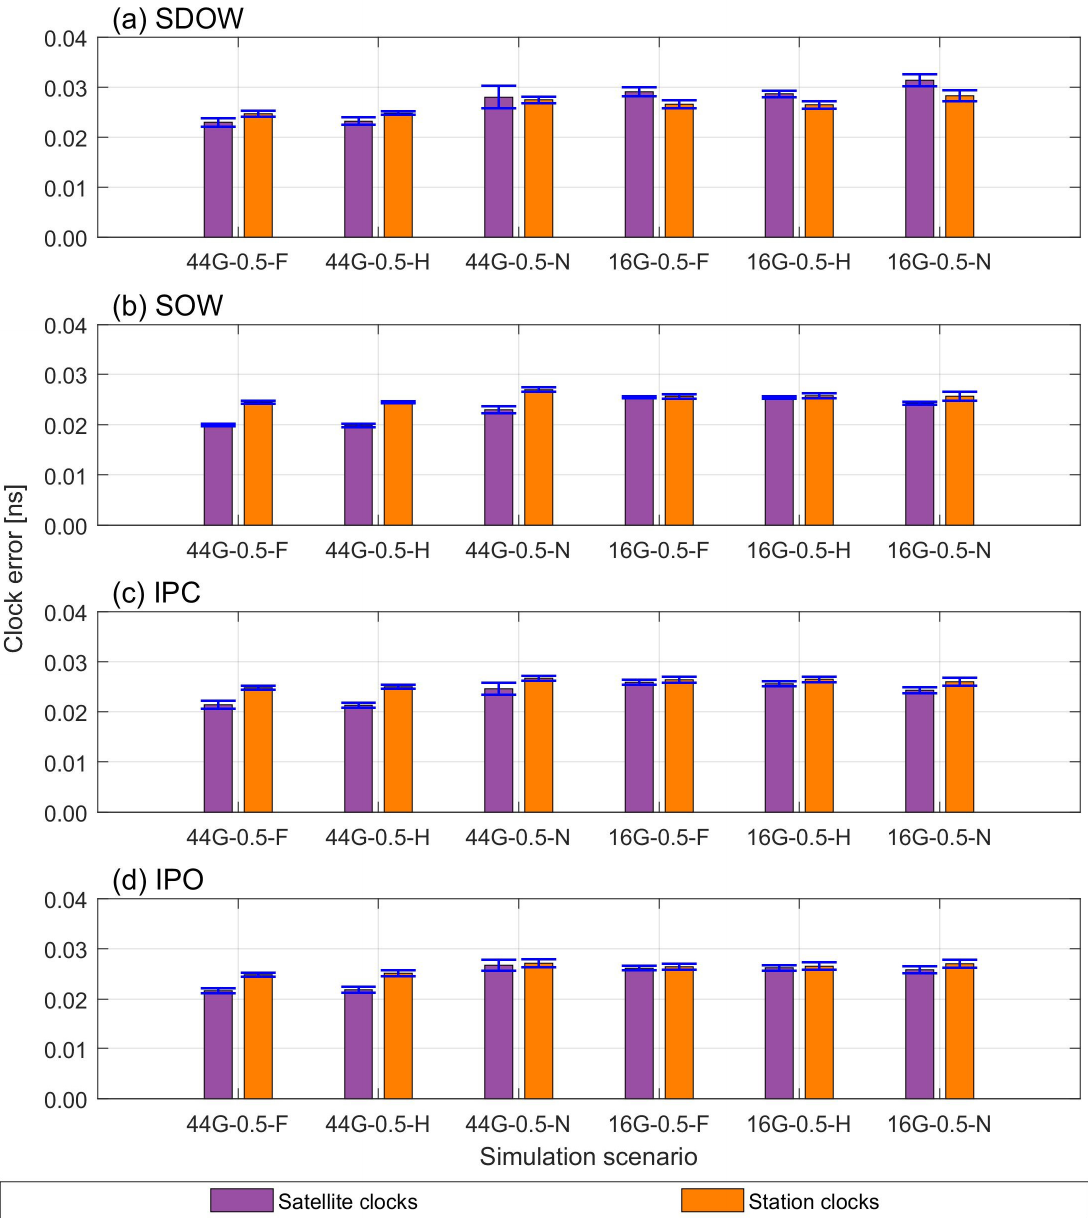
Figure 4. Mean RMS estimation errors for satellite and station clocks considering the station set and VCE approach with respect to connectivity scheme: ( a ) SDOW, ( b ) SOW, ( c ) IPC, and ( d ) IPO. The simulation scenario names are given in Table 3.